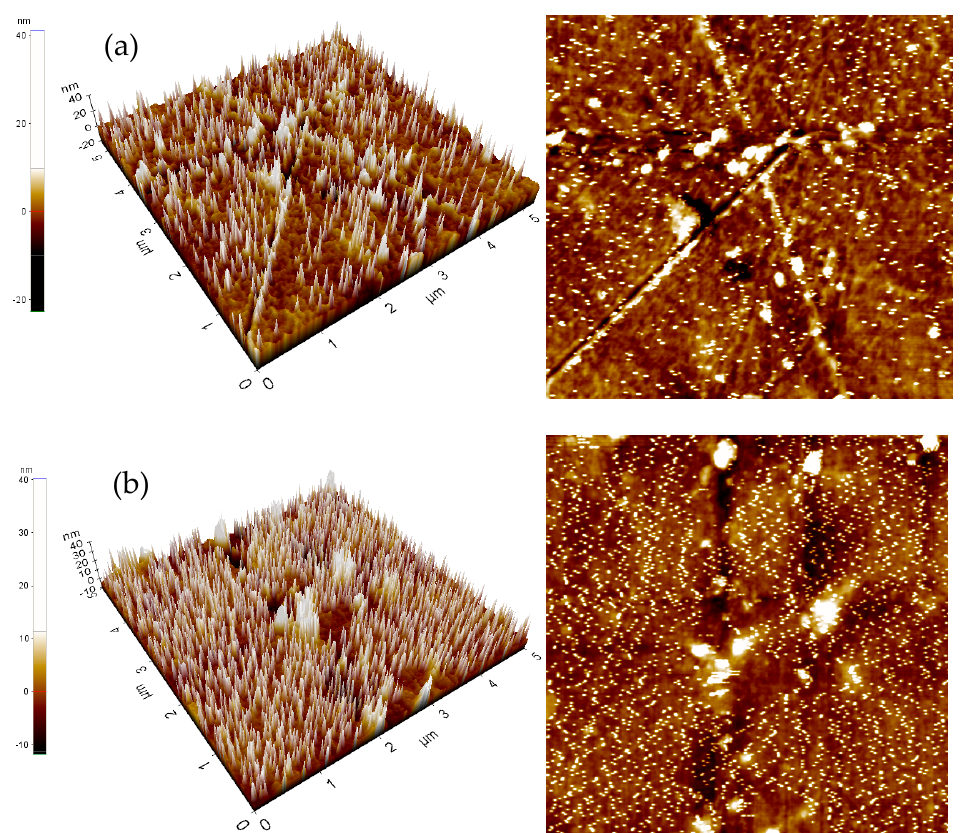
Figure 13. Three-dimensional AFM high and phase images of PET substrate ( a ) before and ( b ) after surface modification.